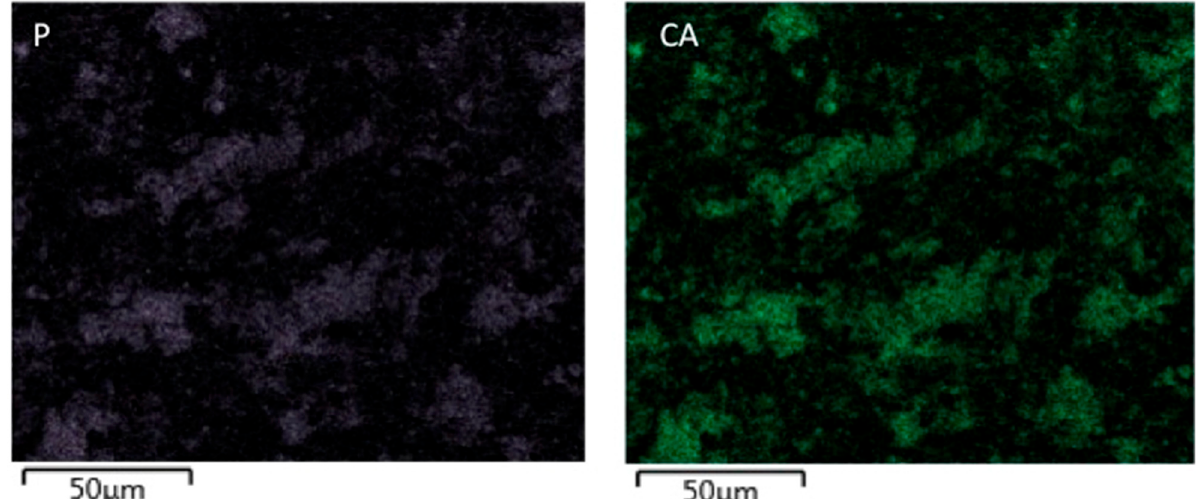
Figure 1. SEM image of HA nanoparticles. These nanoparticles on SEM showed a uniform round shape in mostly agglomerated form with few isolated particles.